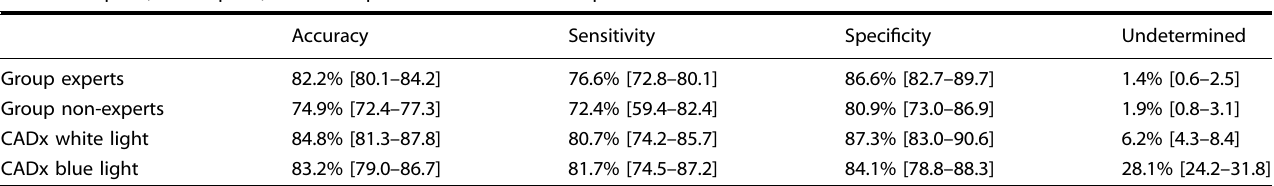
CADx output is provided separately for video frames in white light and video frames in blue light. Expert (10 reviewers) and non-expert (11 reviewers) assessed both white light and blue light video frames. Accuracy, sensitivity, and speci fi city are calculated on the fraction of 513 polyps for which a prediction was provided, using histopathology as the reference standard. The column labeled “ Undetermined" displays the percentage of polyps for which the reviewers or CADx failed to provide a prediction,